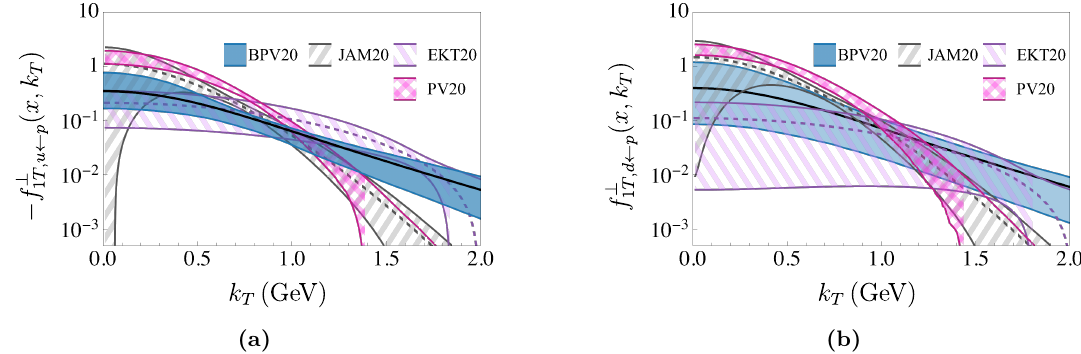
Figure 15. The comparison of the Sivers function extractions in the momentum space for u , d , quarks at x = 0 . 1 and µ = 2 GeV. Our results, black solid line and the blue band, are compared to JAM20 [30] (gray dashed line with the error corridor hatched), PV20 [29] (magenta hatched region), EKT20 [31] (violet hatched region, dashed line).